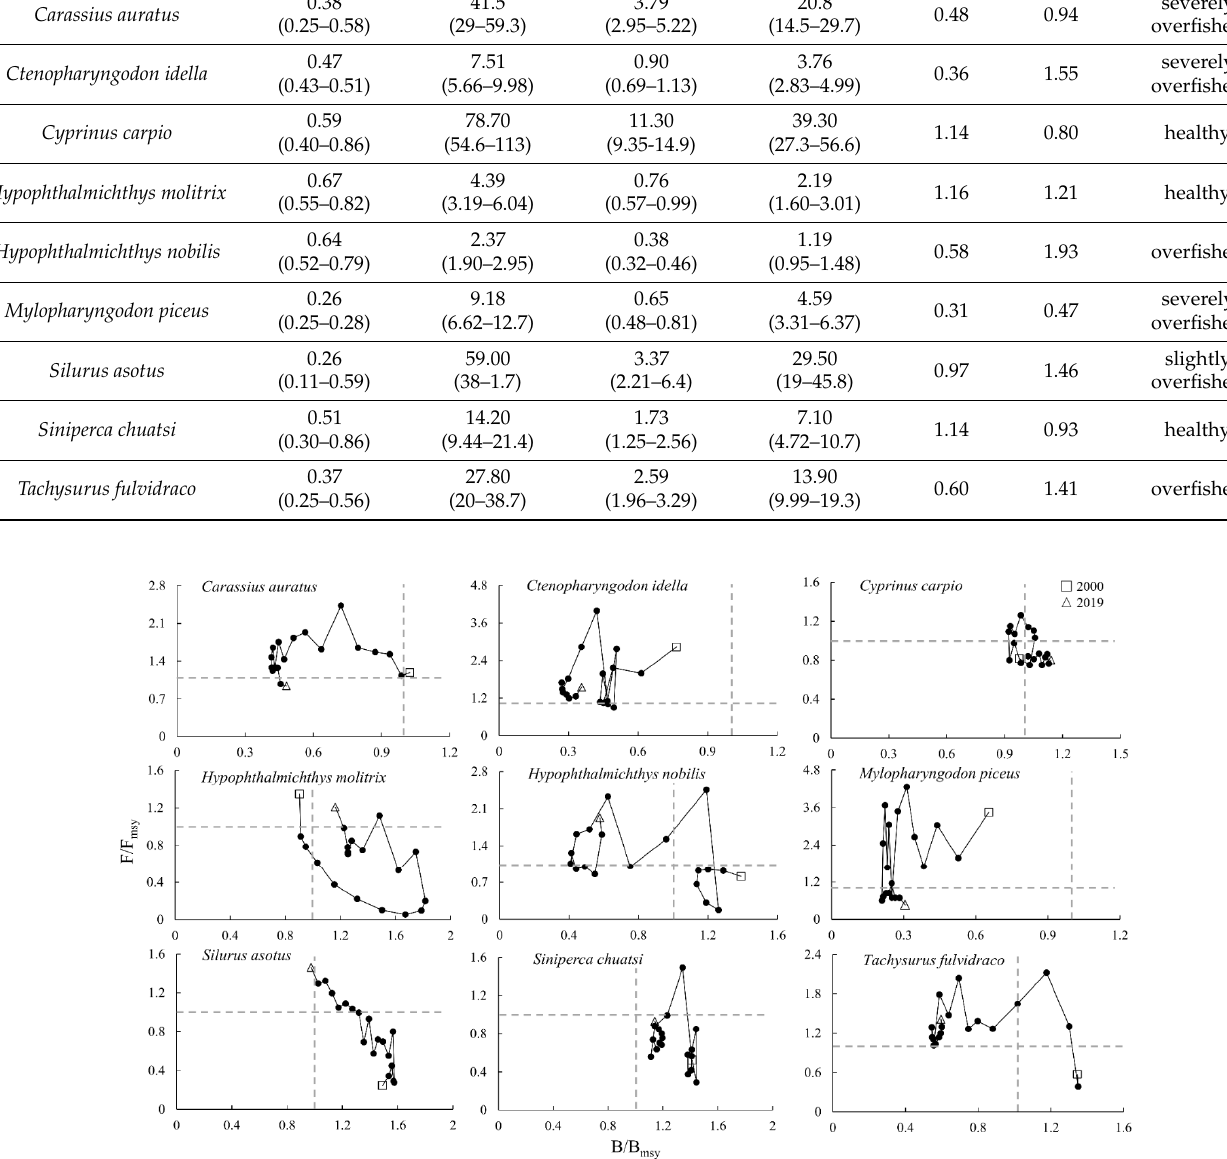
Figure 3. Scatter diagrams between B / B msy and F / F msy extracted from the CMSY models for nine main economic fishes in the Poyang Lake. Square points and triangle points respectively indicate values in 2000 and 2019. Solid black points indicate values in each year, which are connected with black lines sequentially from 2000 to 2019. Gray dotted lines are horizontal lines ( F / F msy = 1) and vertical lines ( B / B msy = 1). The F / F msy > 1 and B / B msy > 1 indicate higher fishing pressure and well biomass, respectively.